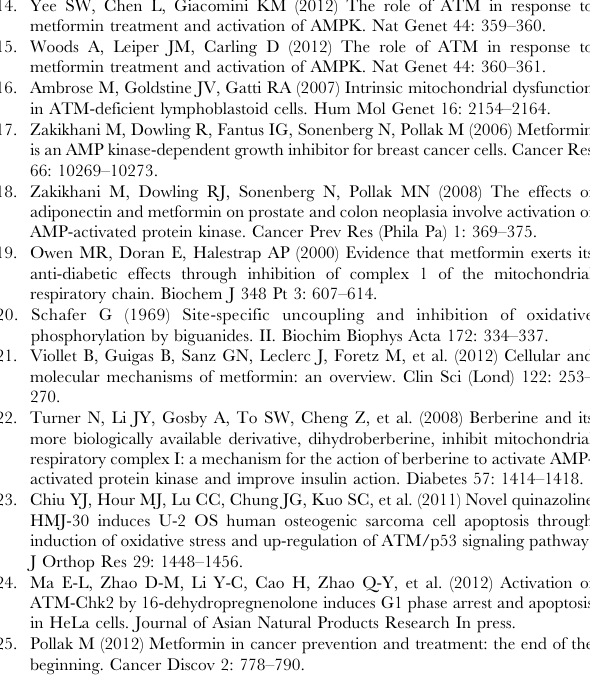
Figure S1 Loss of mitochondrial membrane potential ( DY ) as indicated by flow cytometry is seen by a decrease in FL2/FL1 fluorescence intensity ratio. Results indicate that treatment with